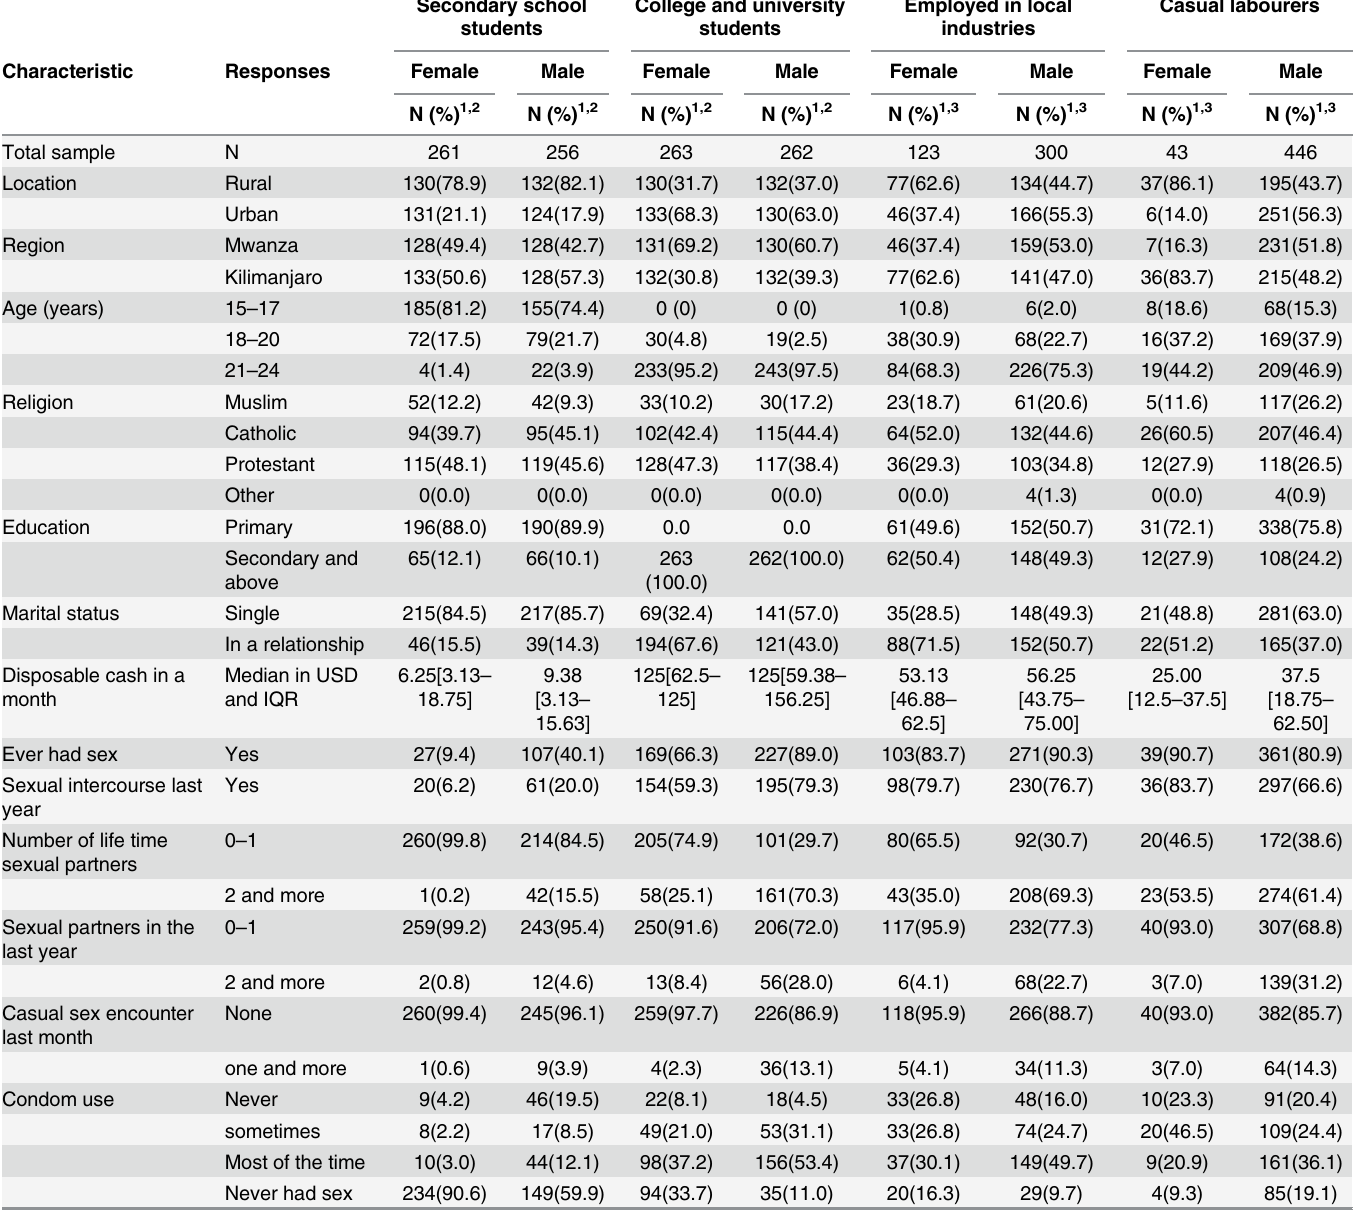
Table 1. General characteristics of the study populations among young people in northern